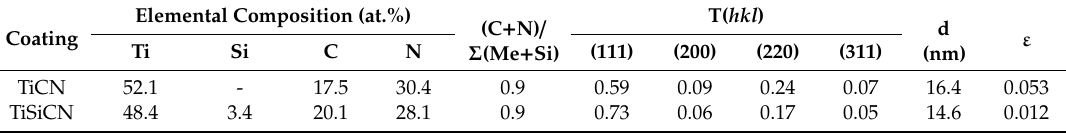
Table 2. Elemental composition measured by EDS, texture coe ffi cient T( hkl ), crystallite size d and strain ε determined by the Williamson–Hall plot